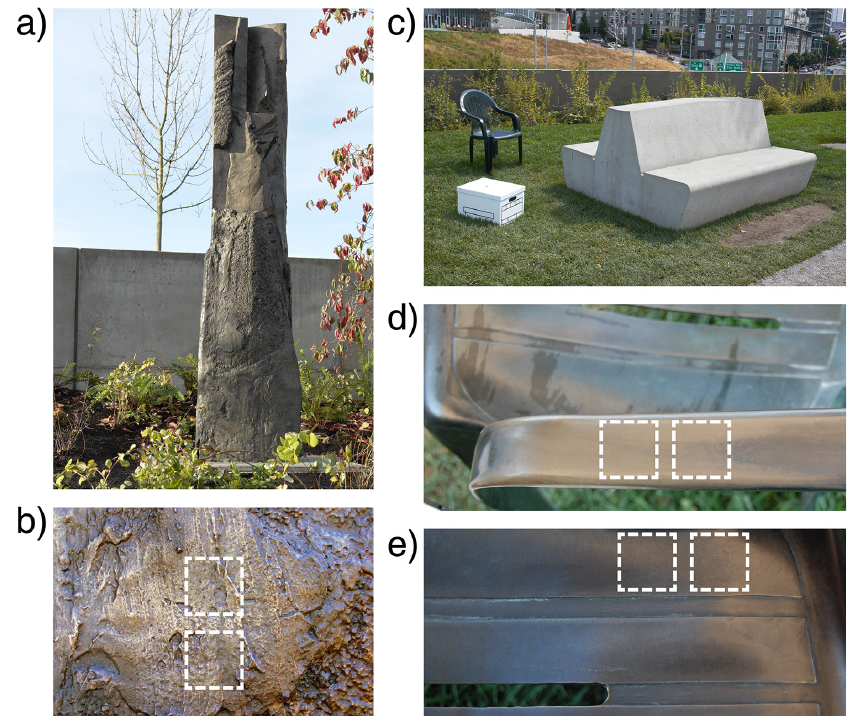
Figure 1. Photographs of the wax-coated bronze sculptures examined at the Olympic Sculpture Park: Persephone Unbound ( a ) and the chair in Untitled ( c , top left corner). The specific areas (3 cm × 3 cm) tested are shown for Persephone Unbound (PPU) ( b ), C1 ( d ), and C2 ( e ), with the white squares marking the approximate areas tested in the Electrochemical Impedance Spectroscopy (EIS) experiments (i.e., the placement of the two hydrogel electrodes).